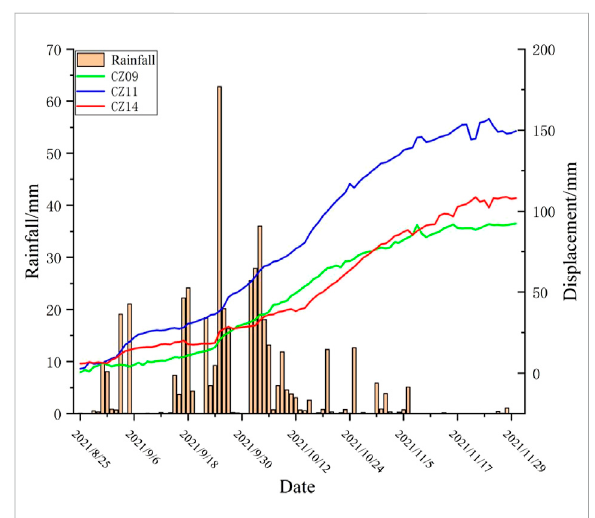
FIGURE 7 The changes of accumulated displacement of landslide and single-day precipitation during the monitoring